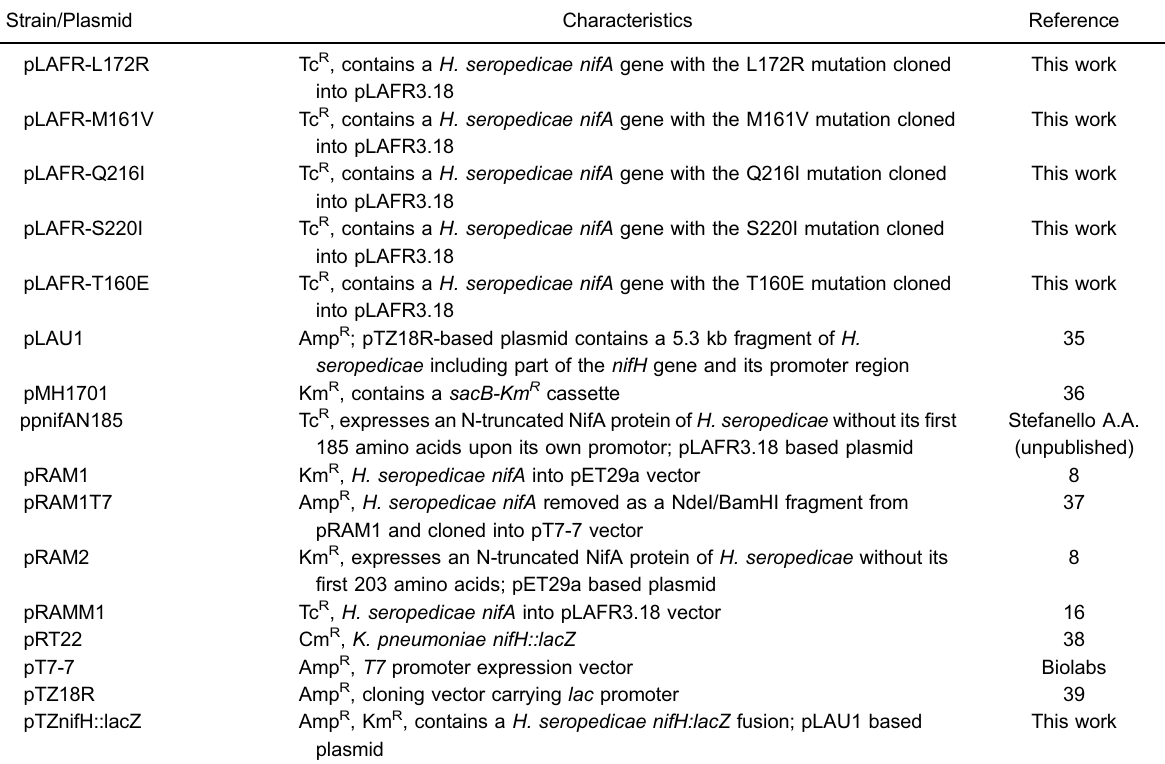
(A215D, Q216I, and S220I) of H. seropedicae NifA (Figure 1). The secondary structure of each mutant protein was predicted using the Psipred tool (21), which indicated no major differences in secondary structure between the mutants and wild-type NifA (data not shown). The ability of the H. seropedicae NifA mutants to activate nif promoters was determined in E. coli JM109 (DE3) carrying plasmid pRT22 ( K. pneumoniae nifH::lacZ fusion) (Figure 2). Full-length NifA, expressed